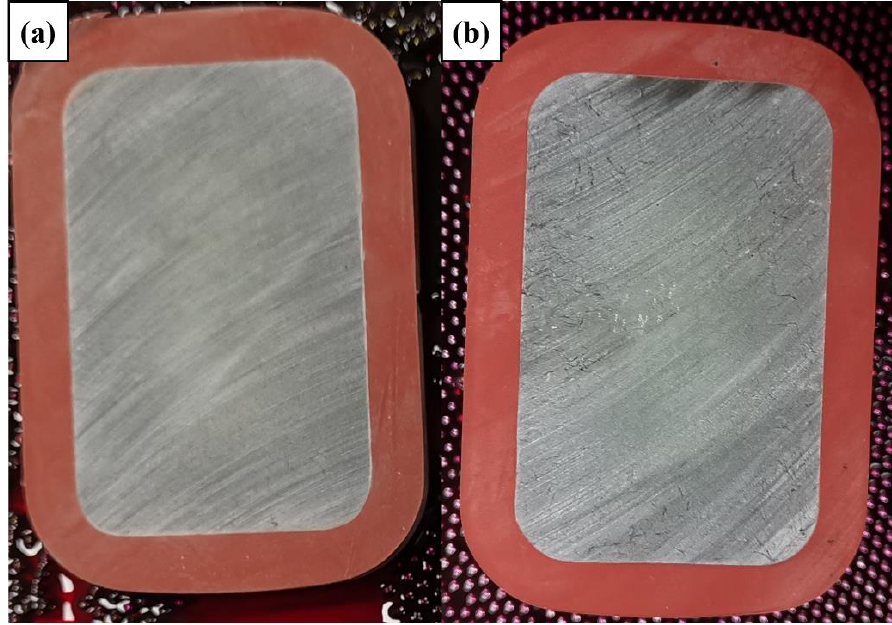
Figure 7. Dye penetration test results for basalt fiber cross arm sample ( a ) and glass fiber cross arm sample ( b ).